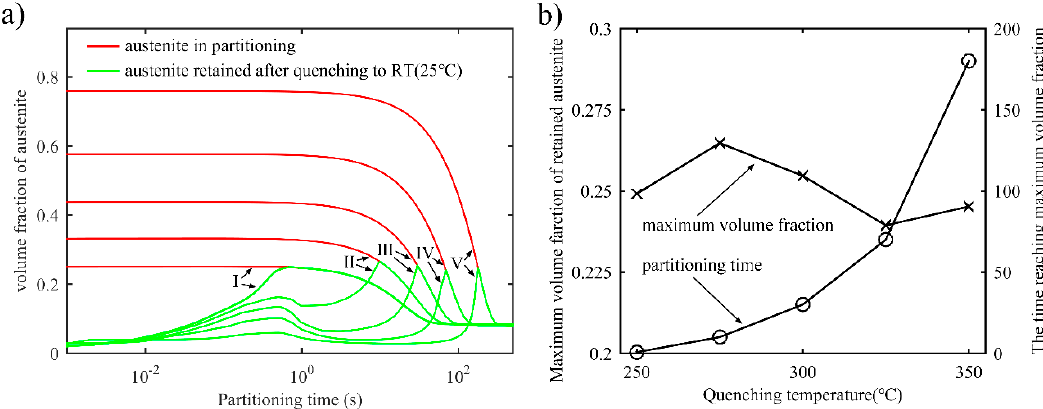
Figure 5. ( a ) Volume fraction of austenite in the partitioning process and retained austenite after quenching to room temperature as a function of partitioning time during the one-stage Q-P process. The partitioning temperature and time are 425 ° C and 500 s, respectively, and the first quenching temperature is: Ⅰ : T Q1 = 250 °C; Ⅱ : T Q1 = 275 °C; Ⅲ : T Q1 = 300 °C; Ⅳ : T Q1 = 325 °C; Ⅴ : T Q1 = 350 °C;